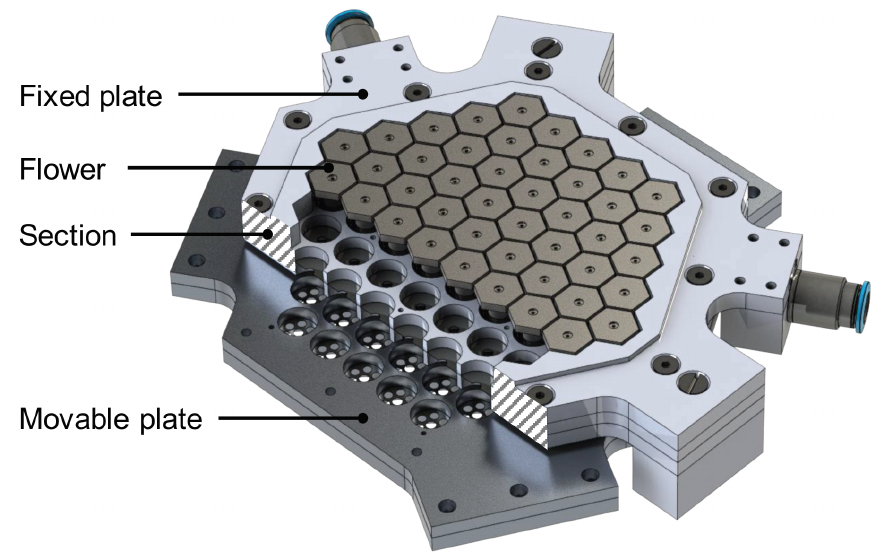
Figure 4. A cross-section of the Flowerbed showing the fixed plate, flowers, and movable plate. Source: [13].